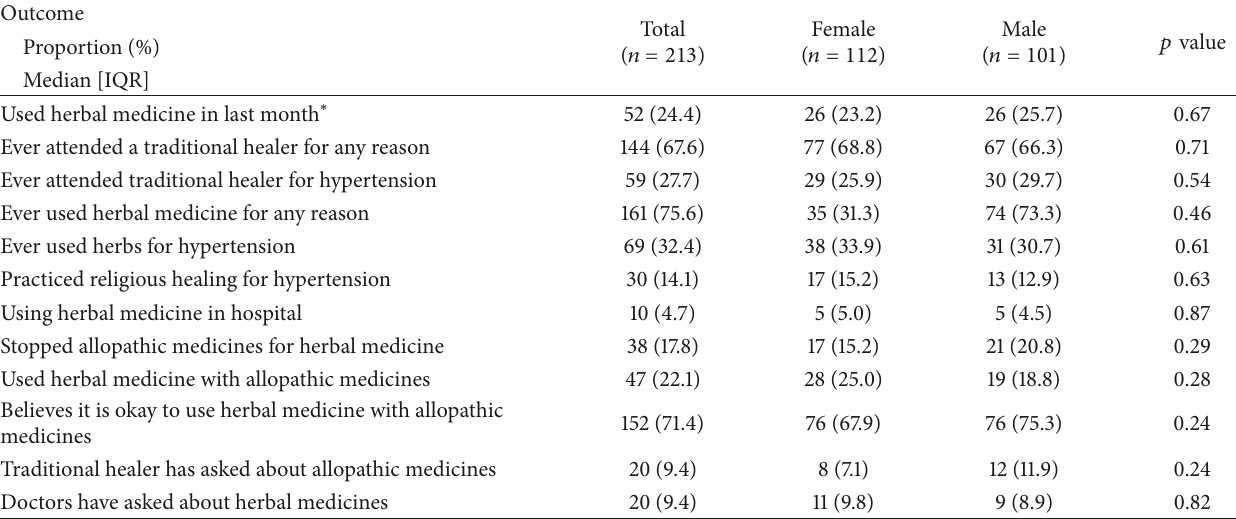
Table 2: Herbal medicine utilization patterns in 213 consecutive adults hospitalized to Bugando Medical Centre with hypertension-related